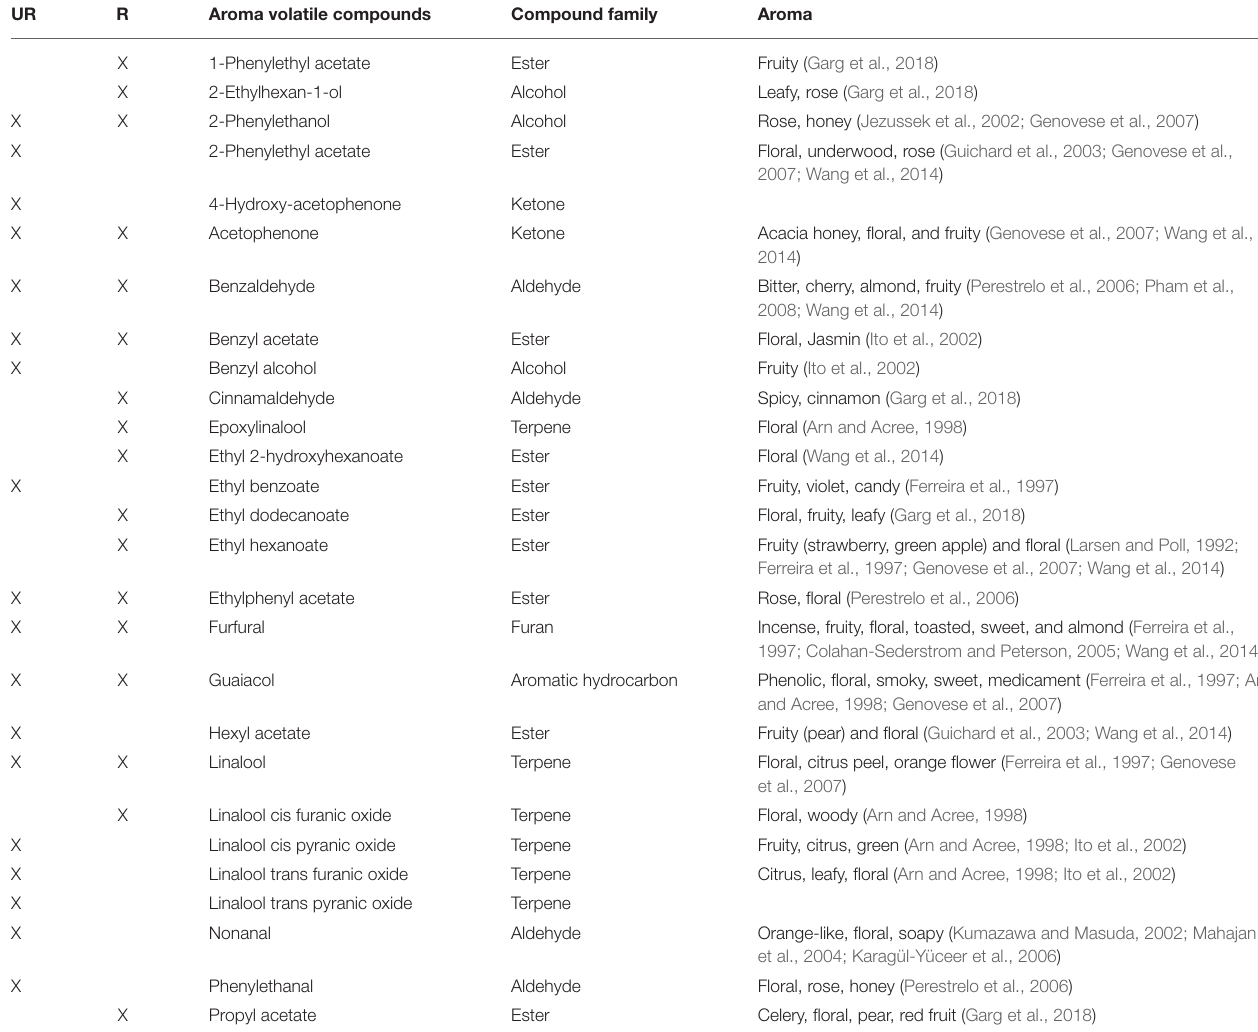
TABLE 1 | List of biochemical compounds related to floral traits used for the GWAS analysis of unroasted (UR) and roasted (R) beans. UR R